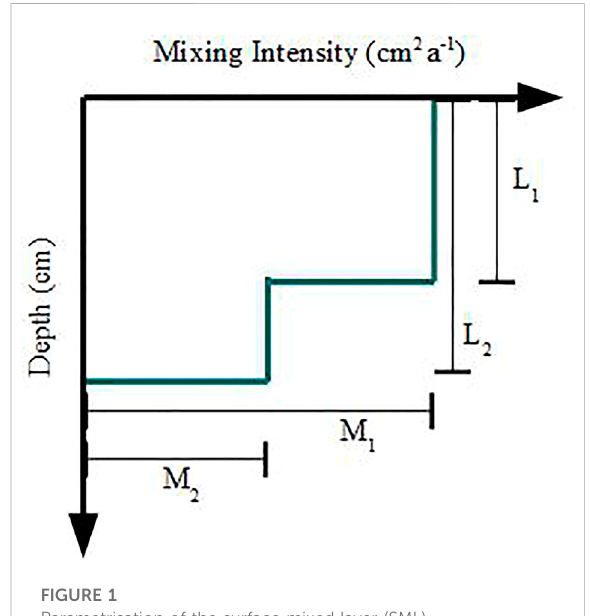
FIGURE 1 Parametrisation of the surface mixed layer